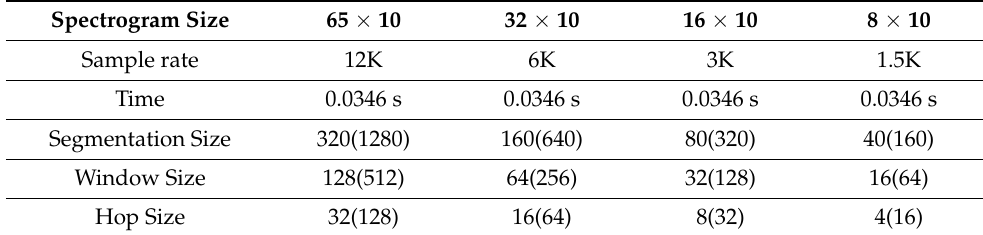
Table 5. Parameters for each spectrogram with different sizes corresponding to different downsam- pling rates.